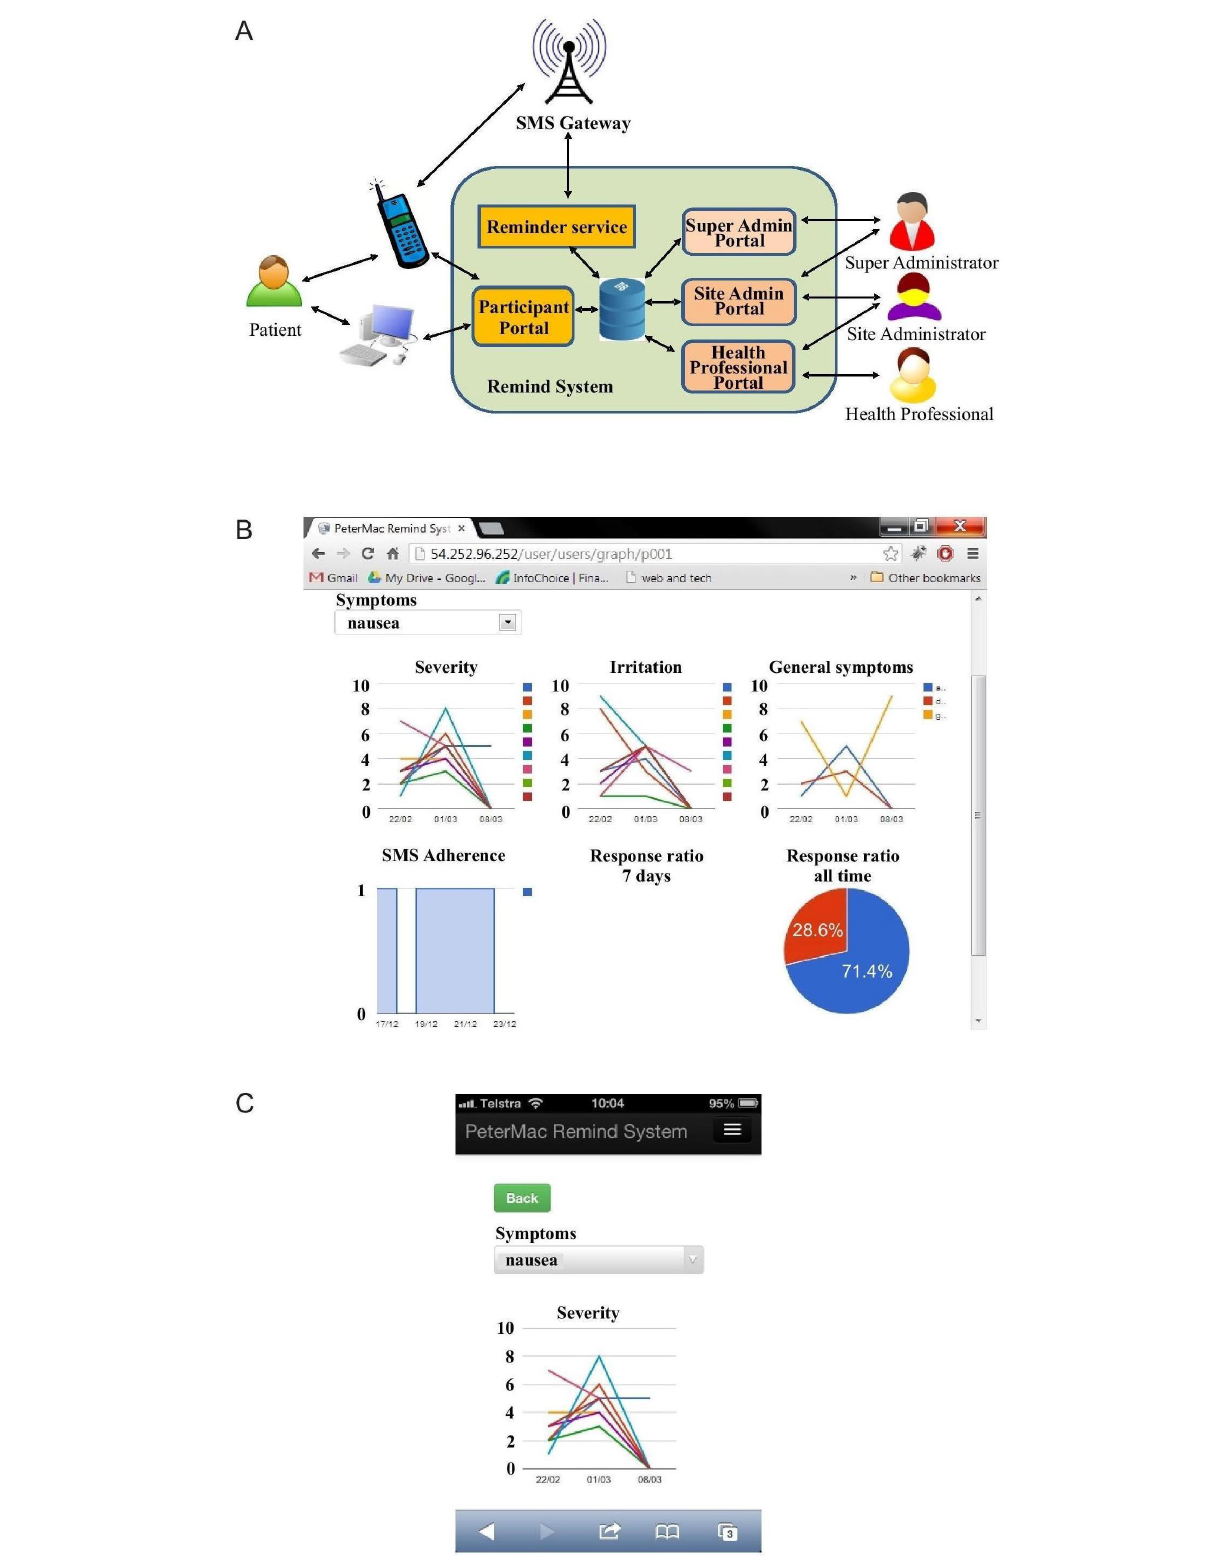
Figure 2. REMIND system representation. (A) Architecture of the REMIND system showing context of interaction with different types of users (patients, health care professionals, and administrators) and external SMS Gateway service. The patient receives reminders on his or her cellular phone, sent from the SMS Gateway, and can interact with the weekly symptoms survey via a browser on a standard computer or a smartphone. (B) Screenshot of patient dashboard, showing graphs (from left to right) of scores (for severity and irritation) for symptom (in this case, nausea) over time, bar chart indicating daily adherence (measured by response), and pie chart showing overall adherence rate. (C) Screenshot of specific symptoms—severity graph for nausea—as displayed on the cellular smartphone